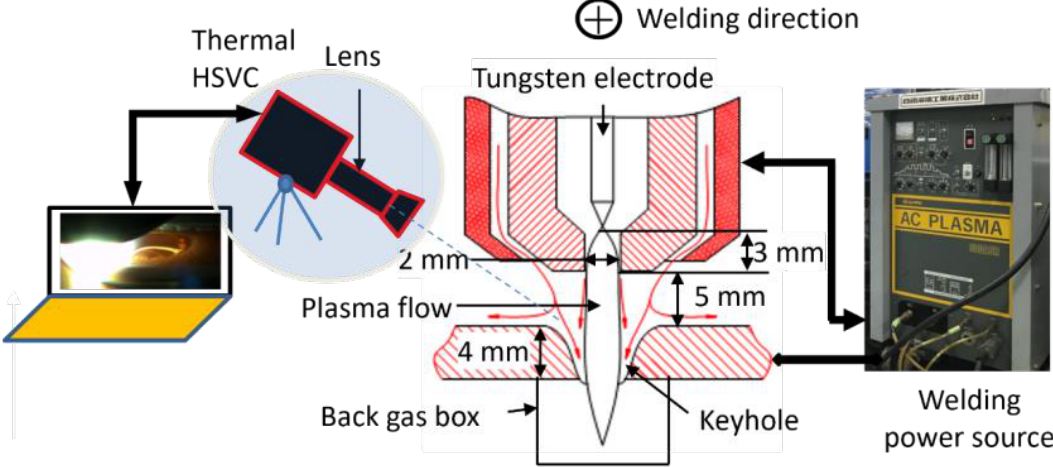
Figure 4. Diagram of temperature measurement on the melted domain surface.